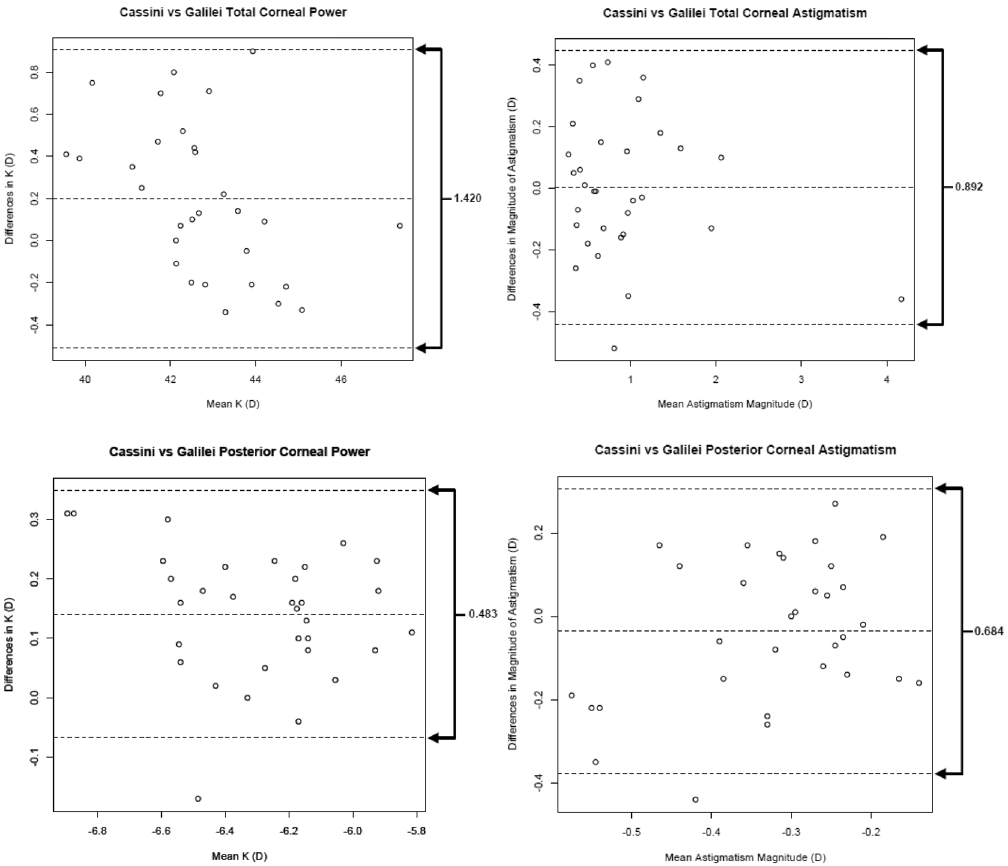
Figure 3. Bland–Altman plots showing differences in corneal power and astigmatism for repeated measurements in normal eyes. The differences were taken between the first and second measurements for each subject. The mean difference is represented by the solid line, and 95% limits of agreement (LoA) are represented by dotted lines. (Top left) total corneal power, (top right) total corneal astigmatism, (bottom left) posterior corneal power, and (bottom right) posterior corneal